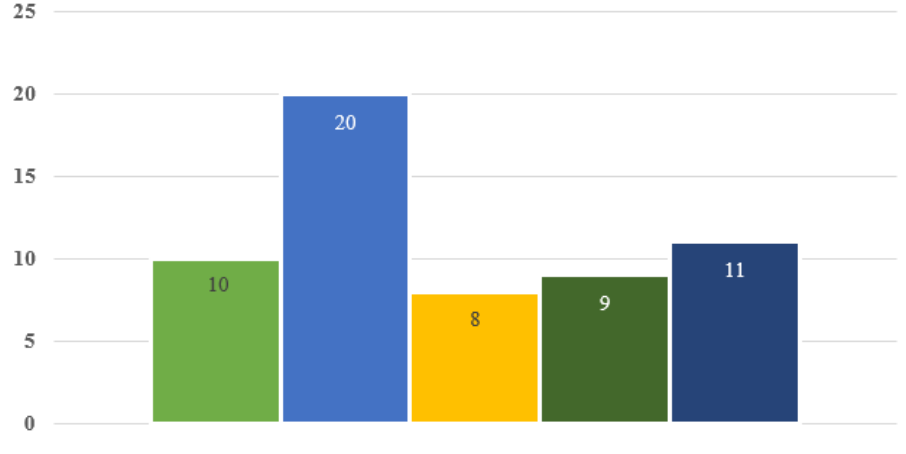
Figure 6. Frequency of meetings/brainstorming sessions.